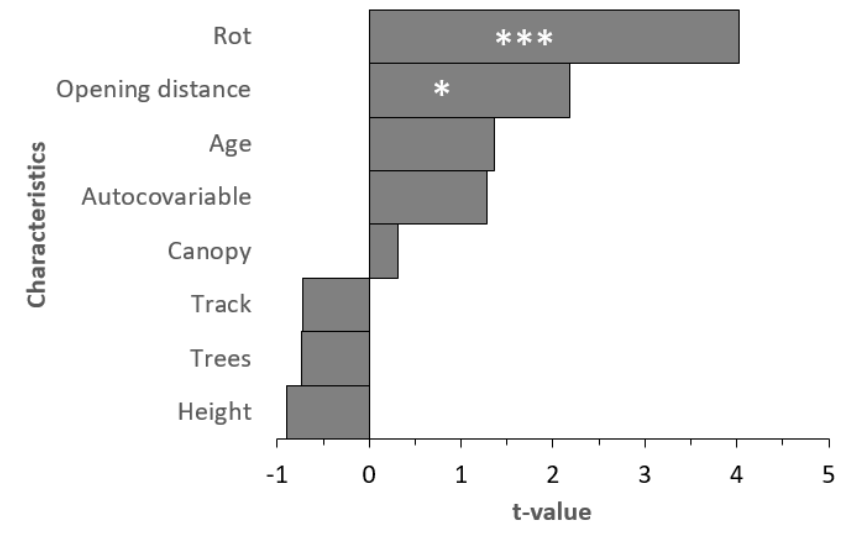
Figure 5. Influence of forest characteristics on the incidence of the carpenter ant in the Czech Republic. * denotes p < 0.05 and *** denotes p < 0.001.